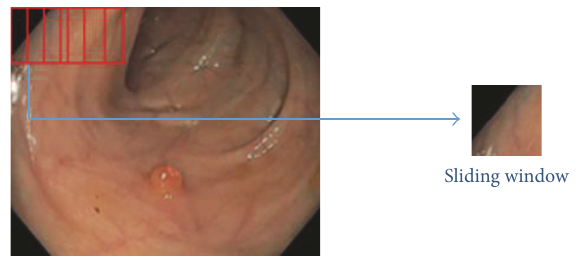
Figure 3: A window of 227 ∗ 227 is sliding along the frame.